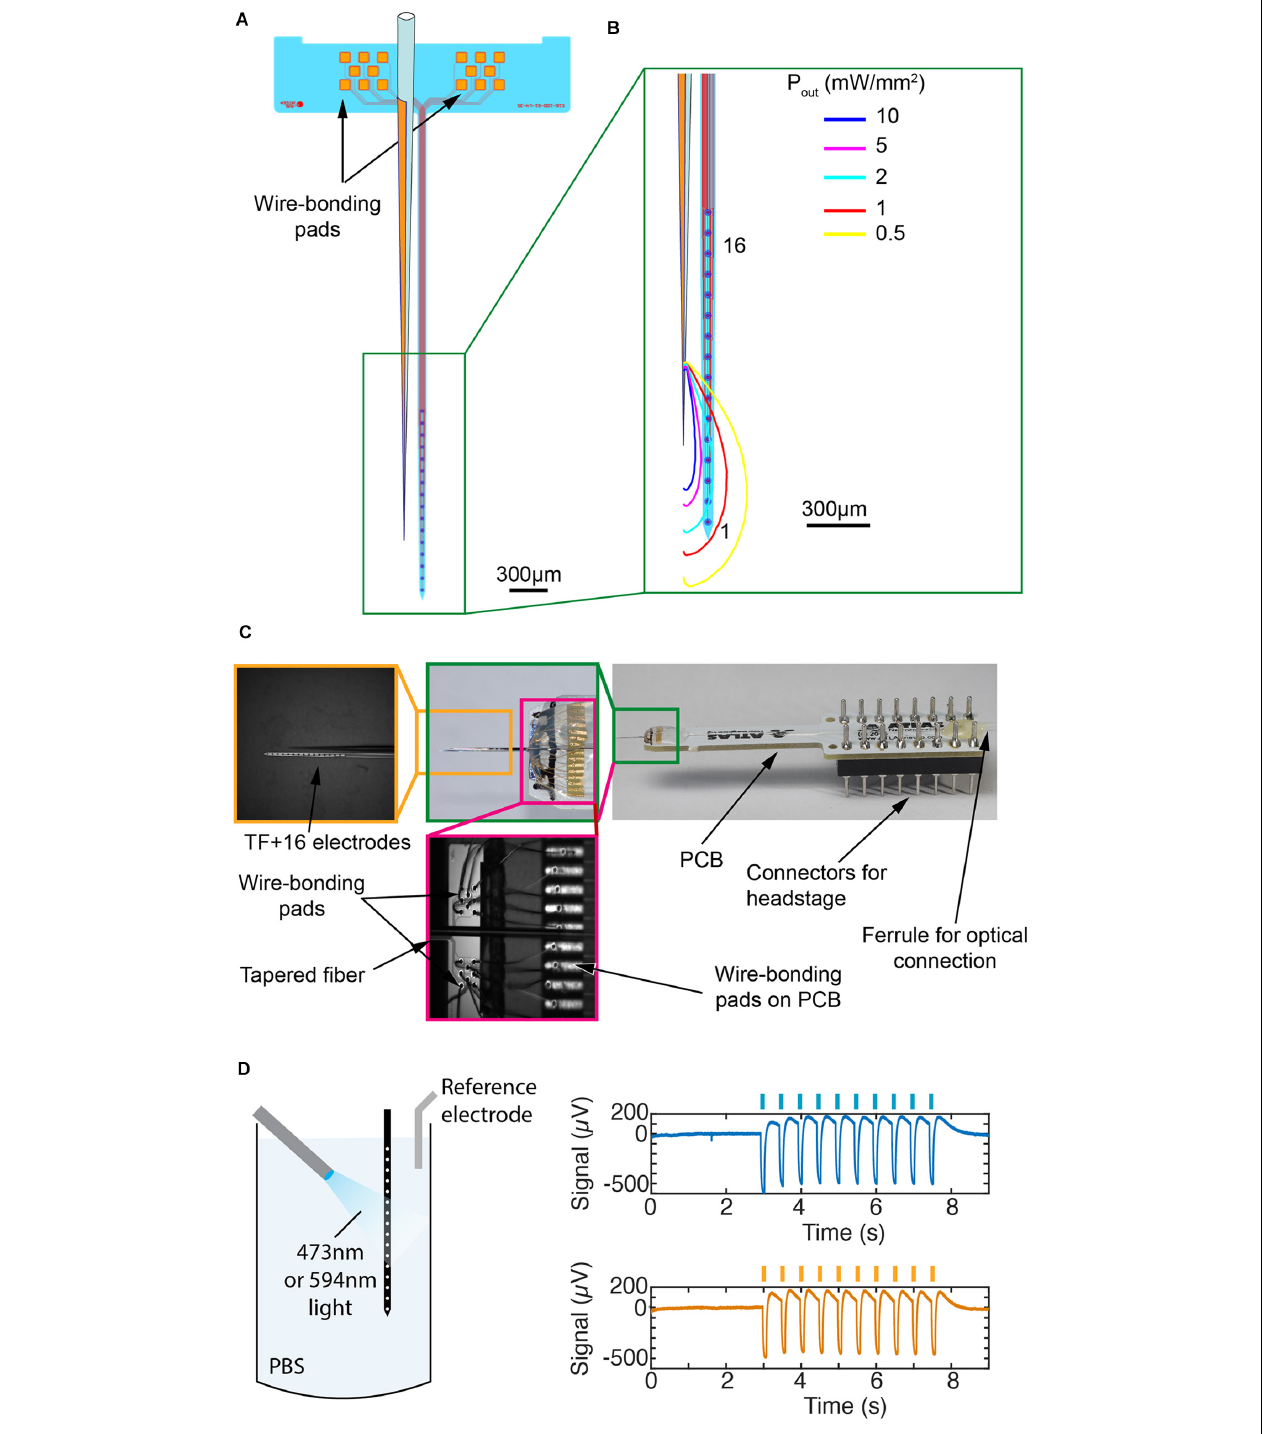
FIGURE 2 | Engineering of the TF-based optrode. (A) Layout of the silicon-based probe array with 16 IrO x recording sites (diameter 35 µ m) arranged at a pitch of 100 µ m along a 4-mm-long probe shank and two groups of bonding pads arranged on the probe base (2.5 mm × 0.58 mm). Fiber position is also reported. (B) Monte-Carlo simulations of power density distribution iso-lines generated by the realized TF and overlapped with a sketch of the microelectrodes array. (C) Final optrode assembly on a PCB (right side) with enlarged view of the wire bonds on the probe base and PCB (center) and the tip region indicating the electrodes and TF (left). (D) Test of photoelectric effect induced by blue or yellow light in PBS. An optical fiber was placed 900 µ m in front of the shank and delivers 200-ms-long pulses of 10 mW at wavelengths of 473 or 594 nm. The two graphs on the right show photoelectric effects generated by both wavelengths (the non-filtered signal is shown). Peak-to-peak amplitudes are 687 µ V ± 13 µ V and 624 µ V ± 8 µ V (mean ± std, n = 10) for the 473 and 594 nm lasers,